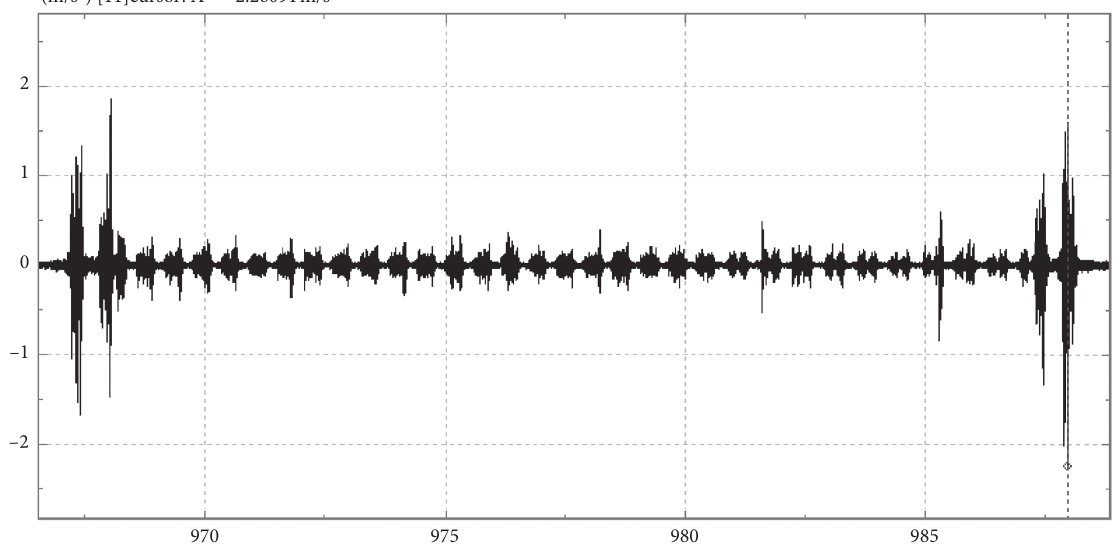
Figure 23: Time domain characteristic diagram of vibration acceleration along the vibration direction ( Z -axis) in the repair zone.